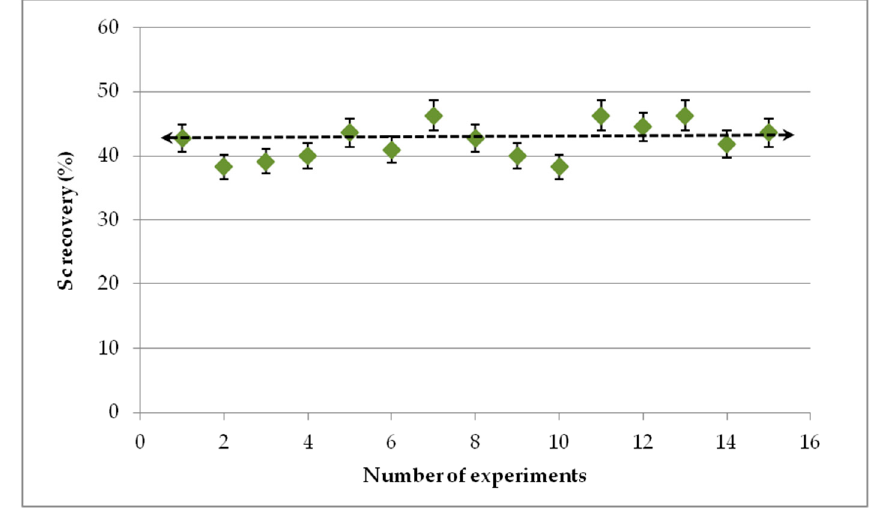
Figure 9. Repeatability of leaching process (S/L 5%, 1 M H 2 SO 4 , t = 60 min).